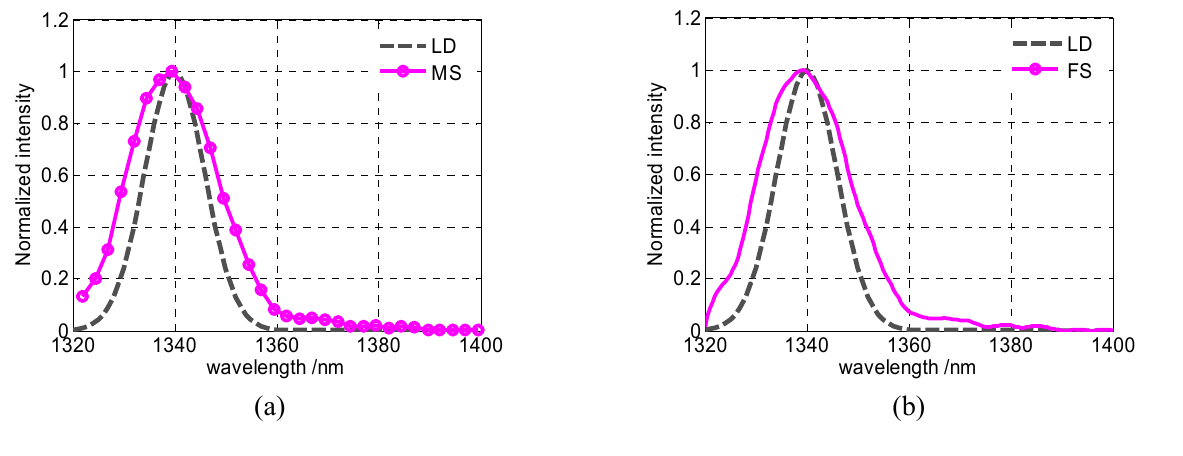
Figure 9. (a) Sampling spectrum of the 1,340 nm interference filter. (b) Fitting spectrum curve of the 1,340 nm interference